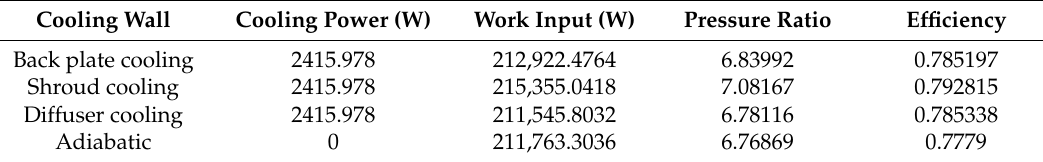
Table 2. Compressor performance by cooling on different